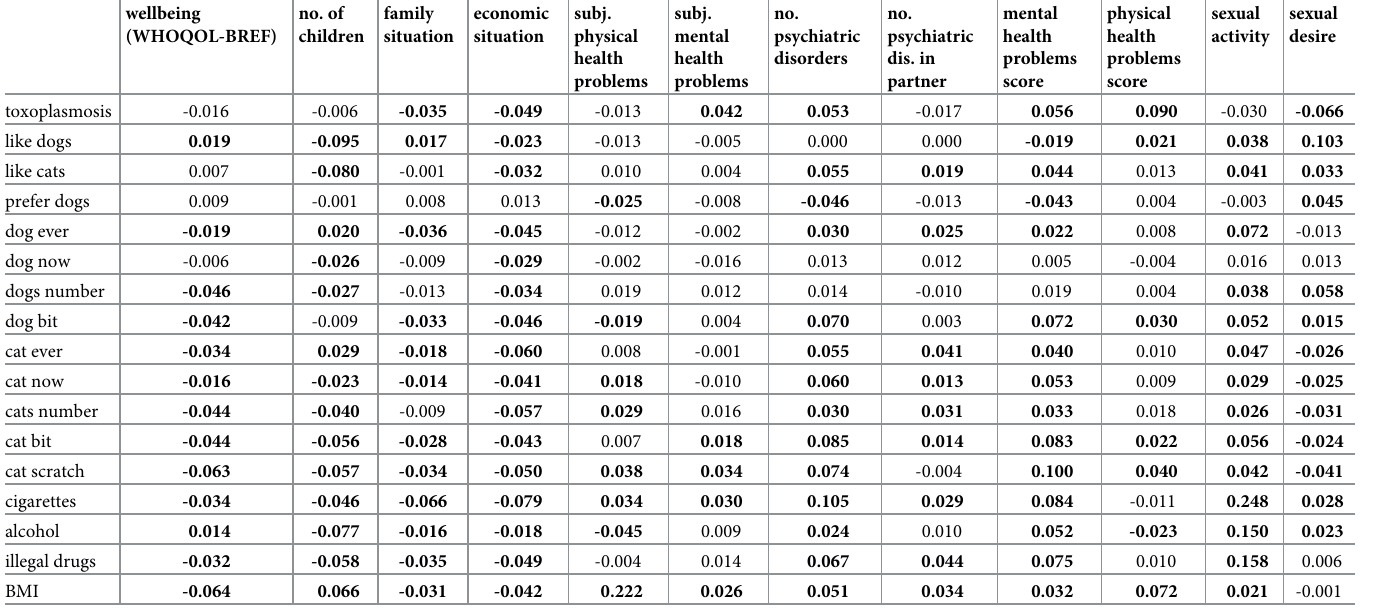
Table 5. Association of animal-related variables with wellbeing and health of female responders. wellbeing (WHOQOL-BREF)